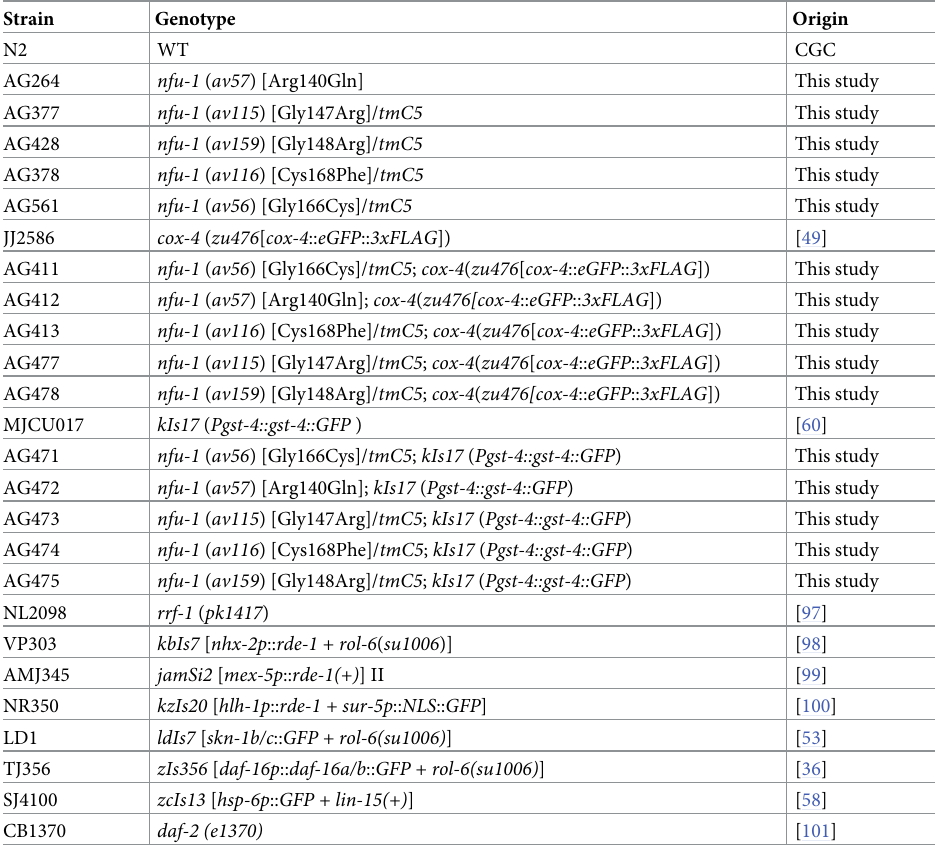
Table 4. Strains used in this